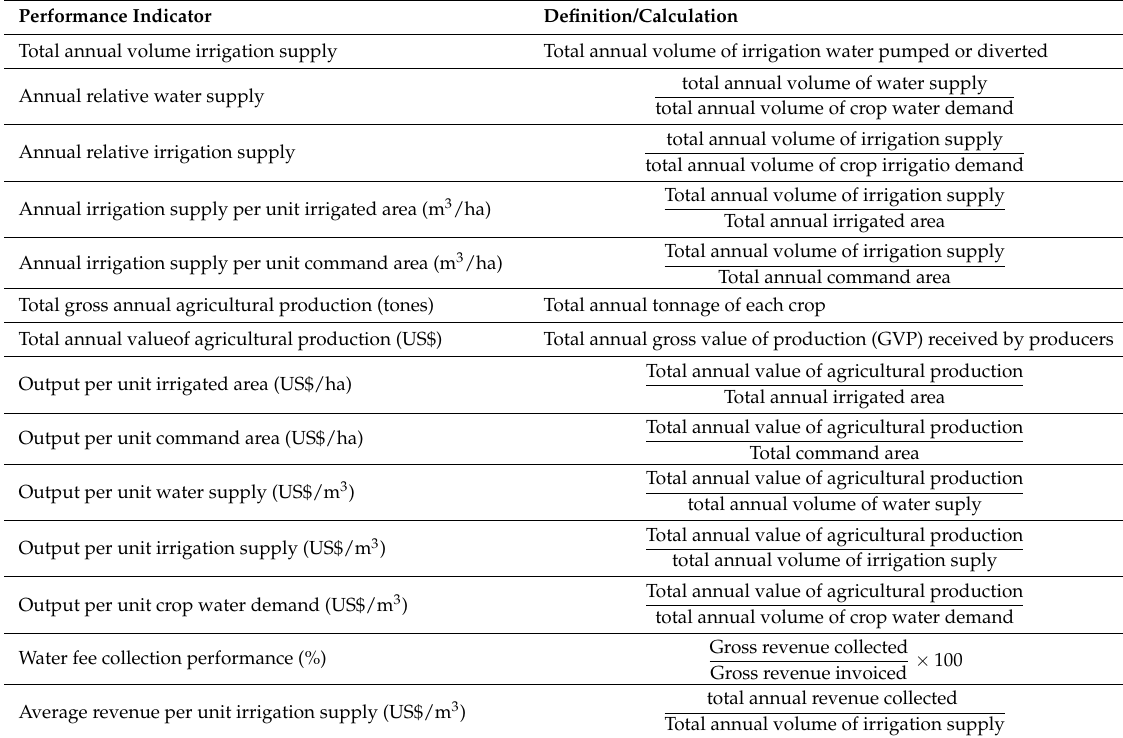
Table 4. Computation of performance